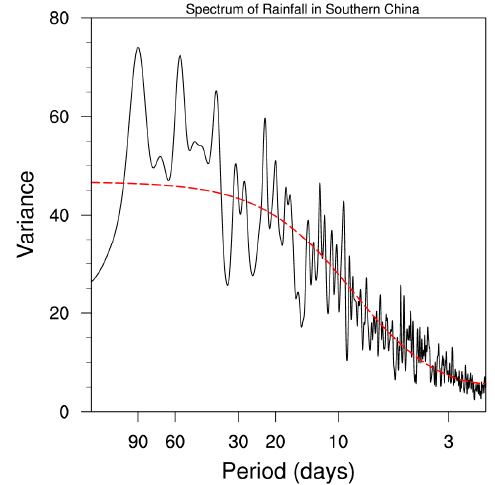
Figure 2. Power spectra of NDJFM rainfall over southern China. Red line represents the red-noise spectrum. The annual cycle is removed before spectrum analysis. Multiple passes of a 1-2-1 filter are applied to all spectra.